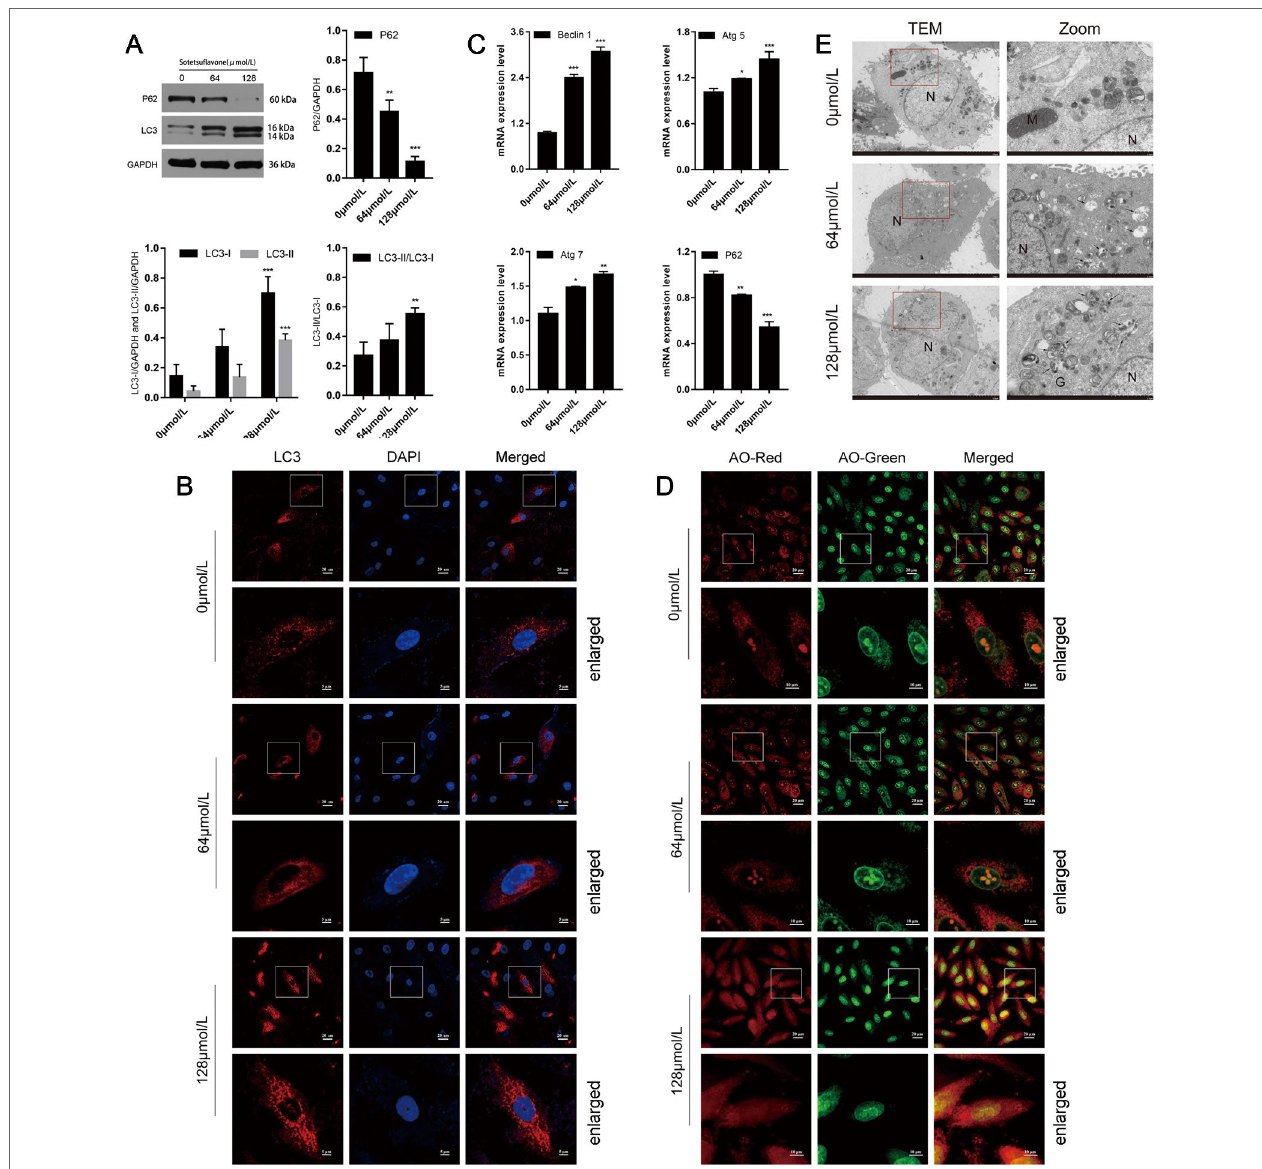
FIgURe 3 | Sotetsuflavone induces autophagy in non-small cell lung cancer cells. (A) The levels of expression of autophagy-related protein (LC3B-I/LC3B-II, P62) in A549 cells treated with different concentrations of sotetsuflavone for 24 h was detected by Western blotting analysis. GAPDH was used as a loading control (** p < 0.01, *** p < 0.001 vs. control). (B) A549 cells were treated with or without sotetsuflavone for 24 h, and LC3 spots were observed under a confocal microscope. Scale bar: 5 μm. (C) RT-PCR was used to detect the levels of expression of autophagy-related genes beclin1, Atg5, Atg7, and P62. Data are expressed as the mean ± SD (* p < 0.05, ** p < 0.01, *** p < 0.001). (D) A549 cells were treated in the absence or presence of sotetsuflavone for 24 h, and then stained with acridine orange (AO). The corresponding merged images are shown on the right. (e) TEM image which depicts the ultrastructure of A549 cells treated without or with sotetsuflavone (64 and 128 μmol/L) for 24 h. N, Nucleus; M, Mitochondria; G, Golgi apparatus. Black arrows indicate autophagosomes or autophagic lysosomes. Scale bar: 2